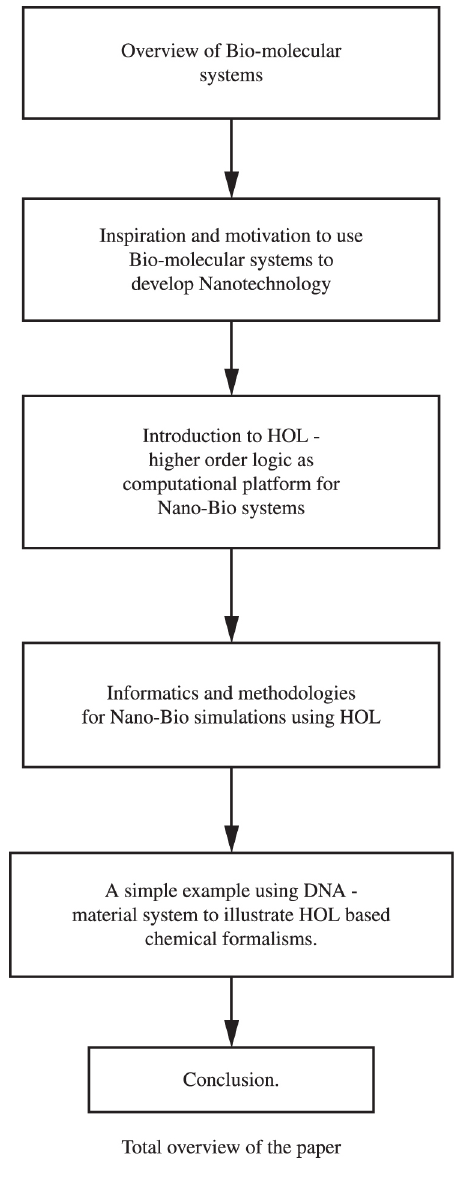
Figure 1. Total overview of the